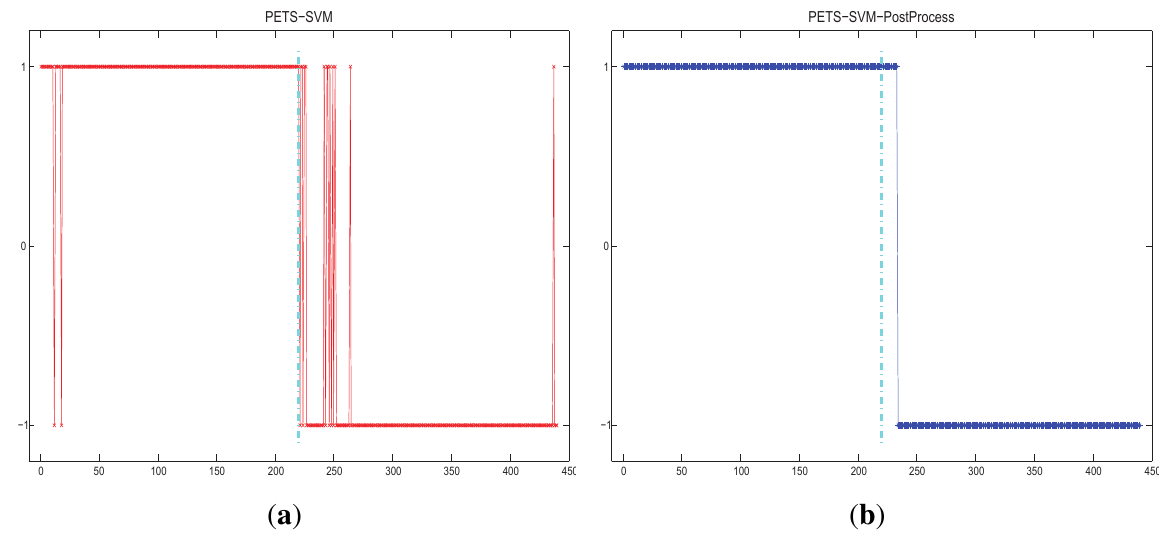
Figure 6. Detection results of the PETS scene. “1” means normal; “ − 1” means abnormal: ( a ) original detection results; ( b ) detection results that are post-processed by the state transition restriction. The consecutive frame number threshold N = 8